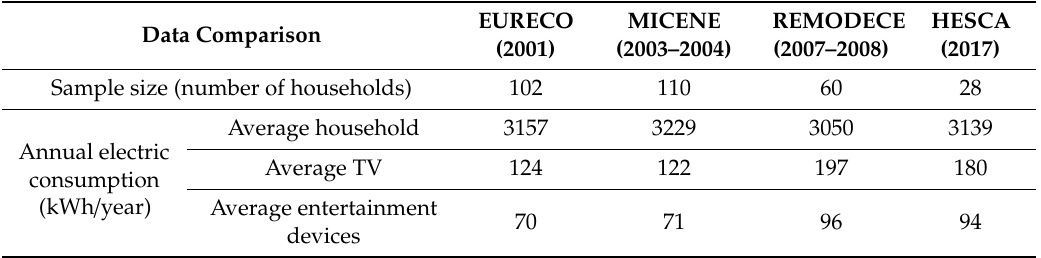
Table 3. Comparison between annual consumptions derived from this study and previous monitoring